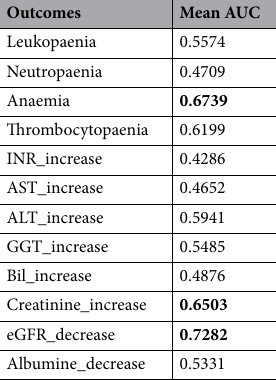
Table 5. Average AUC obtained from subsampling, by outcome. The outcomes that have a predictive performance above 65% are highlightedin